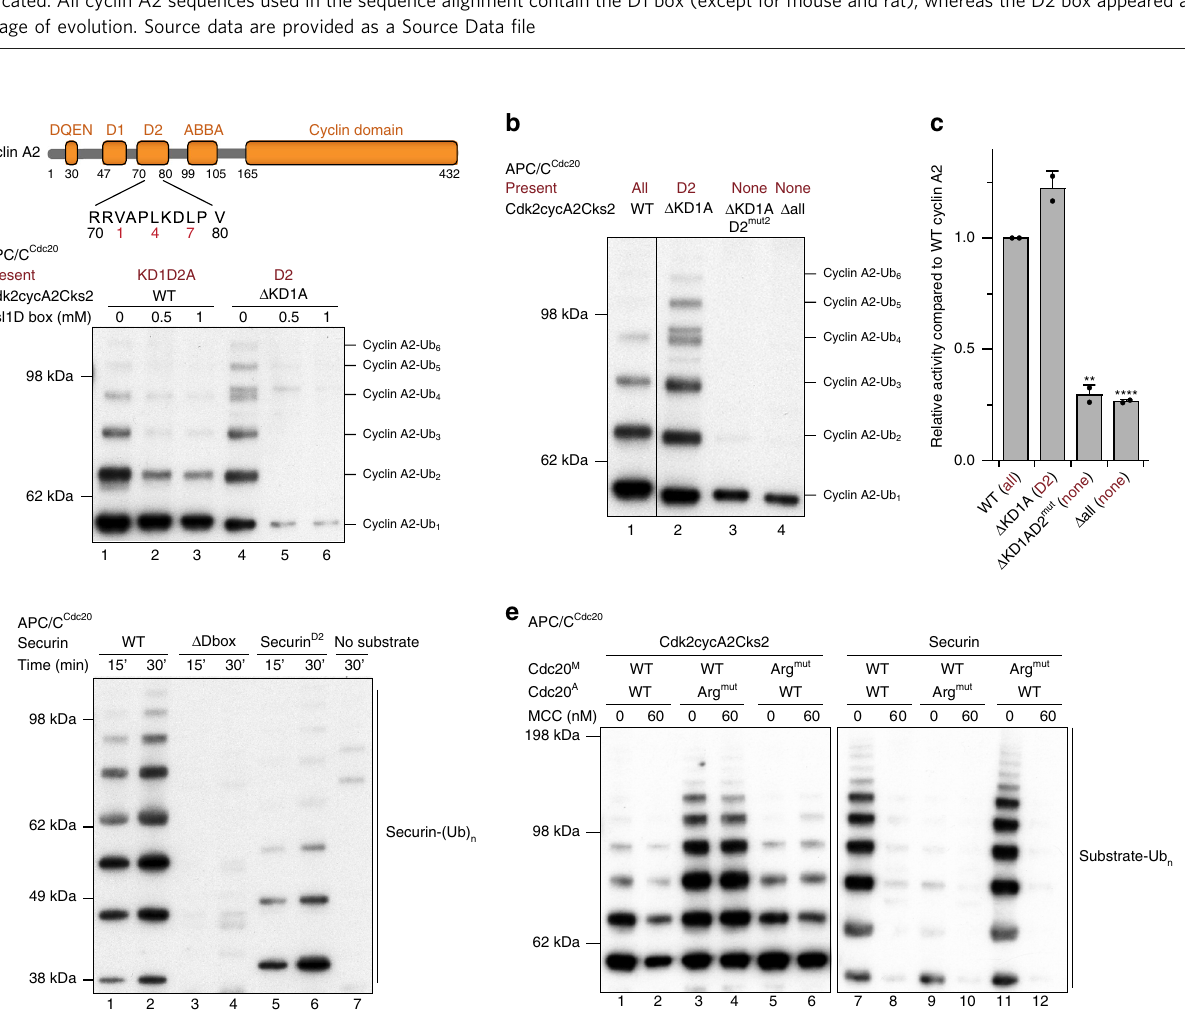
Fig. 3 The identi fi ed degron in cyclin A2 is a non-canonical D box. a Addition of the Hsl1 D box peptide reduced ubiquitination of wild-type cyclin A2 (lanes 1 – 3) and potently suppressed cyclin A2 ubiquitination when only the D2 box was present ( Δ KD1A, lanes 4 – 6). b , c The D2 box alone ( Δ KD1A, lane 2) is suf fi cient to allow cyclin A2 ubiquitination by APC/C Cdc20 , yet additional single mutations at positions 1, 4 and 7 of the D2 box severely impaired its ubiquitination ( Δ KD1A D2 mut2 , lane 3), mimicking the effect when all four degrons were mutated ( Δ all, lane 4). The Western-blot was quanti fi ed to show the effect of individual mutations, with error bars indicating standard deviation. The APC/C activity towards cyclin A2 mutants is normalized to ubiquitination of wild-type cyclin A2 and signi fi cance is calculated using unpaired Student ’ s t -test (indicated with stars, n = 2, Supplementary Table 2). d Insertion of the cyclin A2 D2 box into securin rescued its ubiquitination (securin D2 , lanes 5 and 6) from loss of its native D box (lanes 3 and 4). e Disrupting the P1 Arg-binding pocket for the D box (D177S&E465S) enhanced cyclin A2 ubiquitination by APC/C Cdc20 , but ablated securin ubiquitination, indicating that the D2 box binding leads to more ef fi cient ubiquitination than the D1 box. Source data are provided as a Source Data fi le classes onto Cdc20 WD40 revealed that the N-terminal segment of wild-type Cdk2-cyclinA2-Cks2 in complex with APC/C Cdc20 differs from the D2 box class due to a 20 Å shift of Cdc20 WD40 , both the D1 and D2 boxes are similar (Fig. 4e, f). However, unlike with a distinct long-kinked loop structure assigned to the D1 box the D2 box, the C-terminal region of the D1 box folds back and is (Fig. 4d, e and Supplementary Fig. 5h). Superposition of the two sandwiched between Cdc20 WD40 and Apc10. NATURE COMMUNICATIONS| (2019) 10:3863